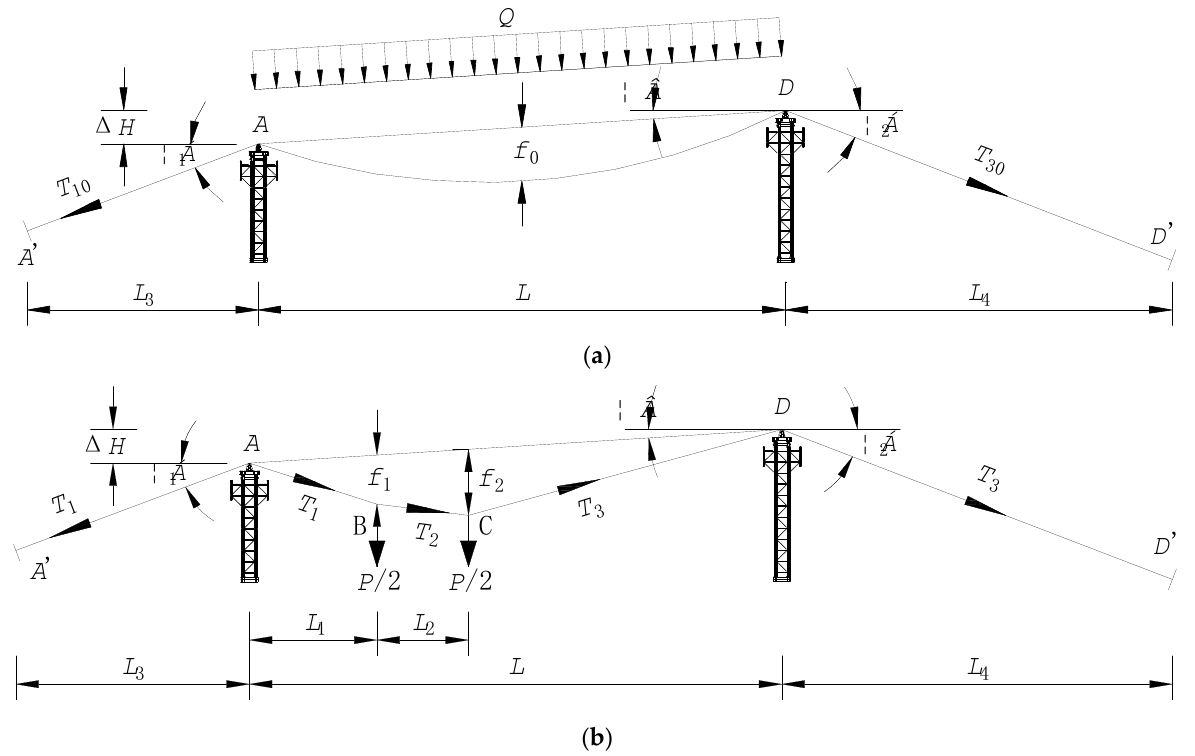
Figure 3. Schematic diagram for calculating the forces acting on the towers from the main cable: ( a ) empty cable; ( b ) cable carrying load.